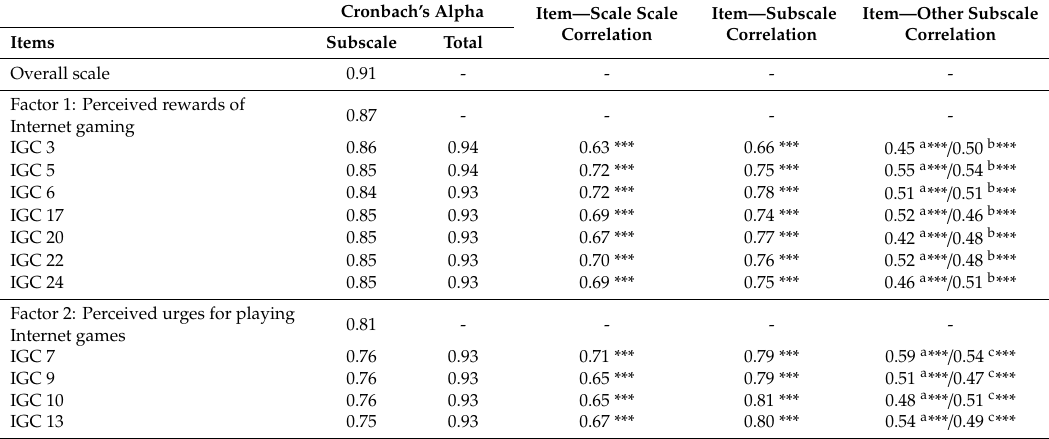
Table 5. Internal consistency, test–retest reliability, and item analysis of the Chinese version of revised Internet Gaming Cognition